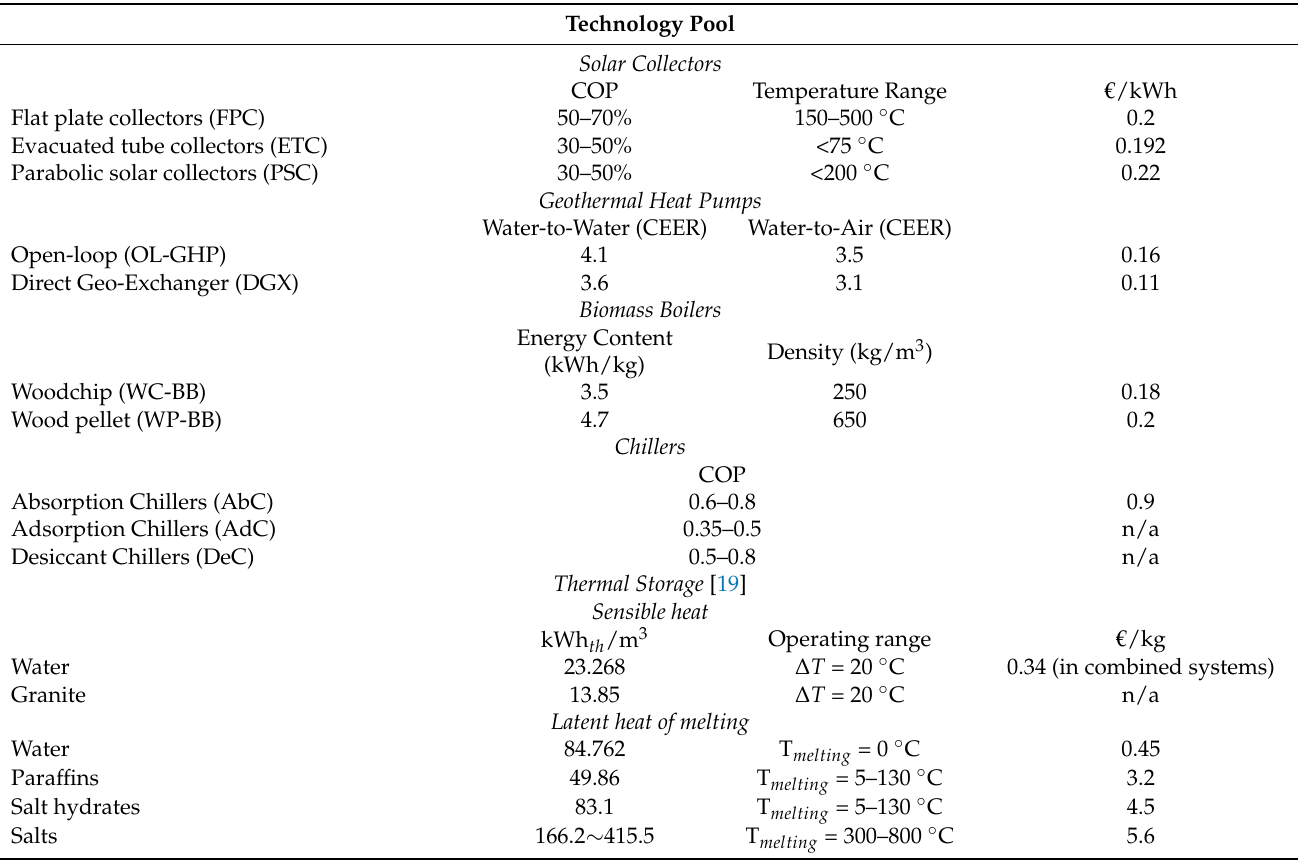
Table 3. Technologies used for the exploitation of the primary resources available